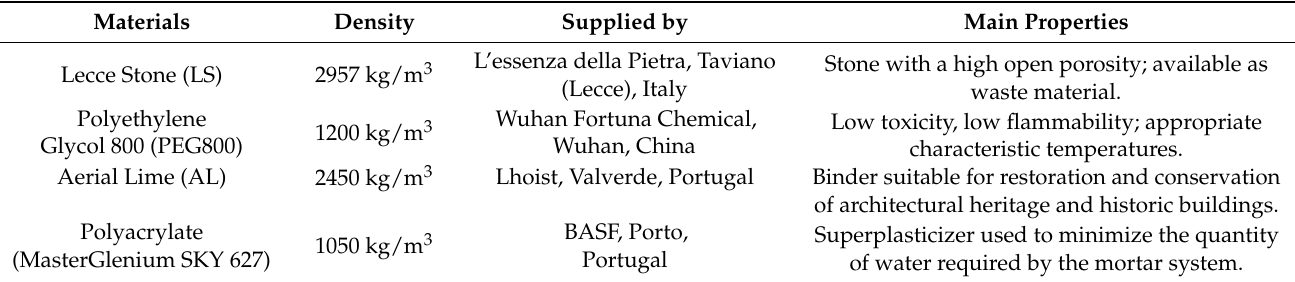
Table 1. List of materials used in this work and description of their main properties.